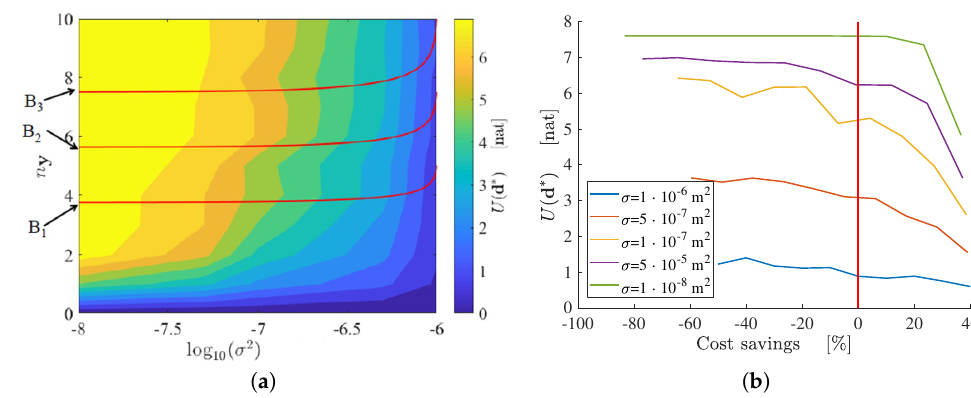
Figure 1. ( a ) Contour plot of U ( n y , σ ) , where lines represents the budget constraints B = C ( σ , n y ) , with B 1 = 2000 e , B 1 = 2500 e , B 1 = 3000 e ; ( b ) Pareto front of the expected Shannon information gain with respect to the SHM system